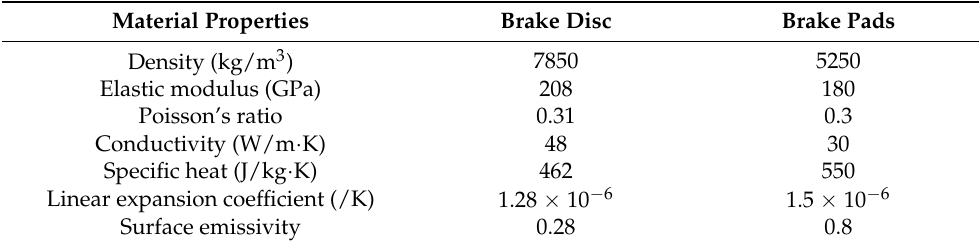
Table 1. Material properties of the ventilated brake disc and brake pads.